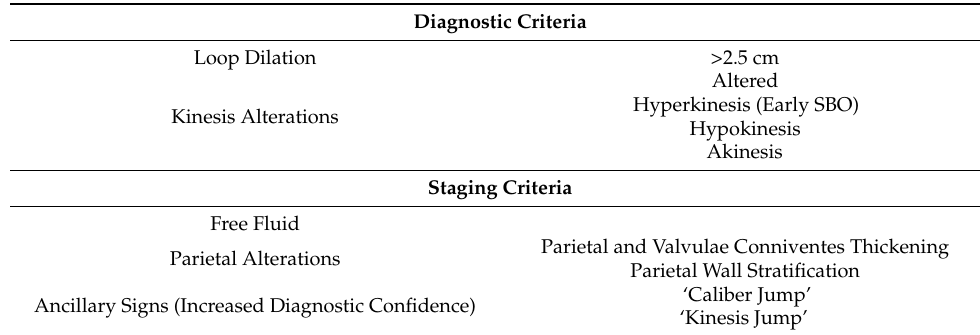
Table 2. Ultrasound signs of